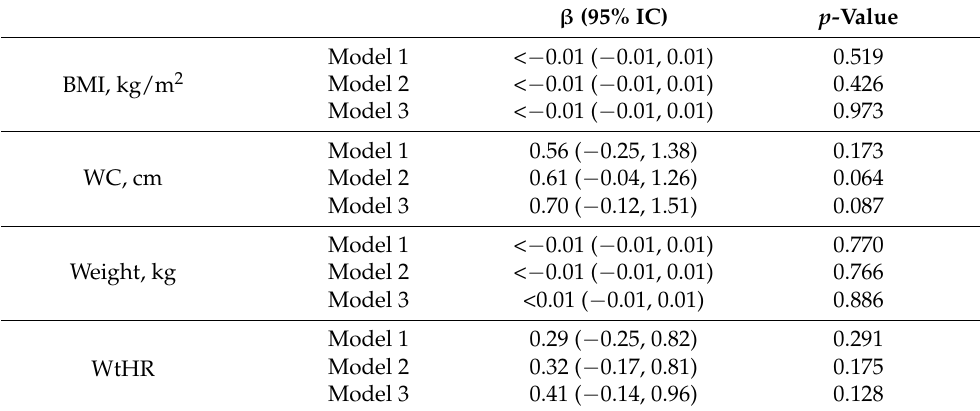
Table 2. Association between anthropometric variables and urinary tartaric acid ( μ g/mg creatinine).